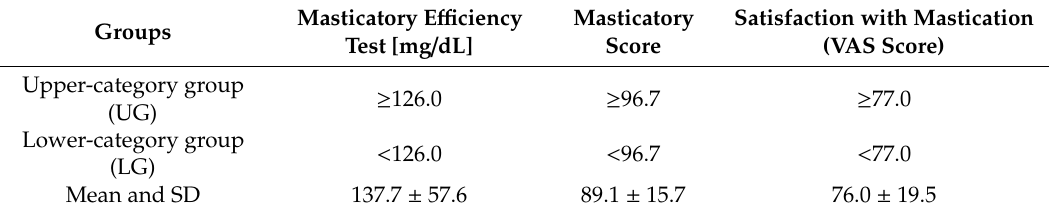
Table 2. Regression analysis categorizations for the three masticatory ability assessments.